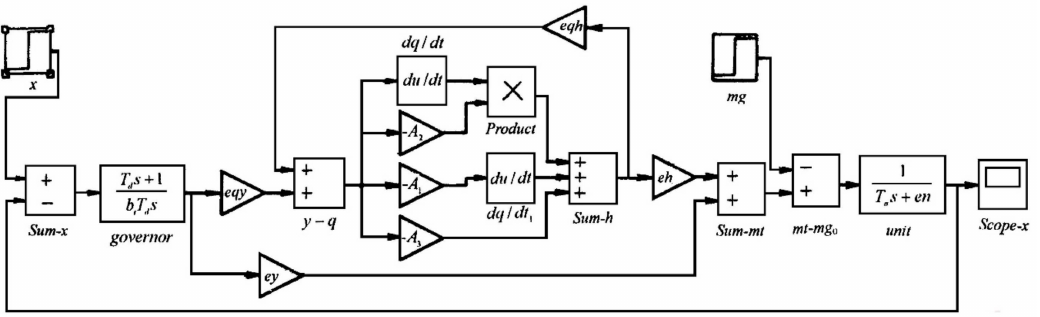
Figure 24. Block diagram of HTGSes with SCTTs